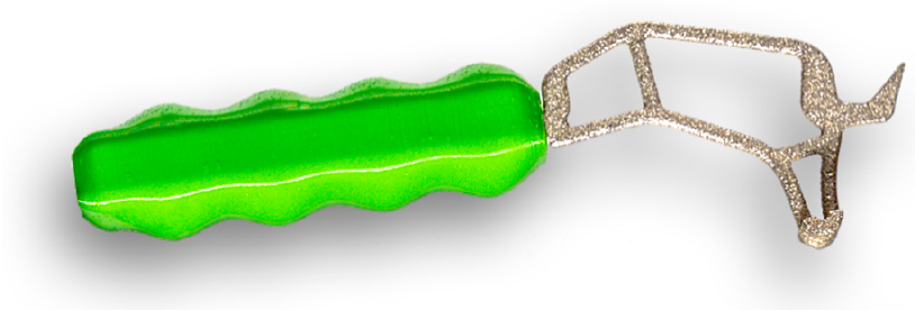
Figure 13. Three-dimensional printed optimised assistive device.